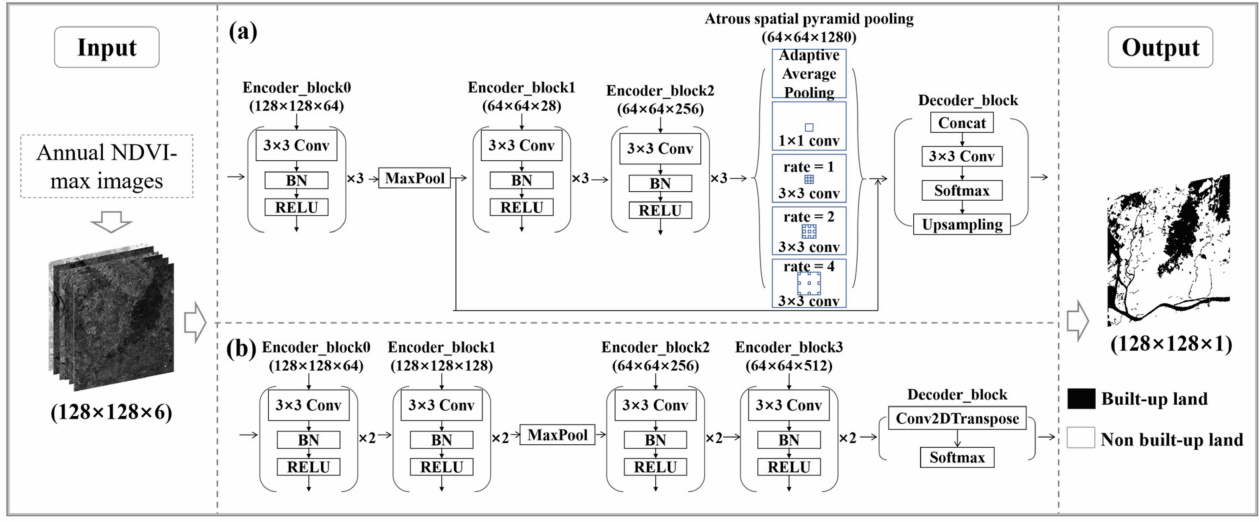
Figure 7. The structure of the compared model. ( a ) the structure of Deeplab-v3; ( b ) the structure of